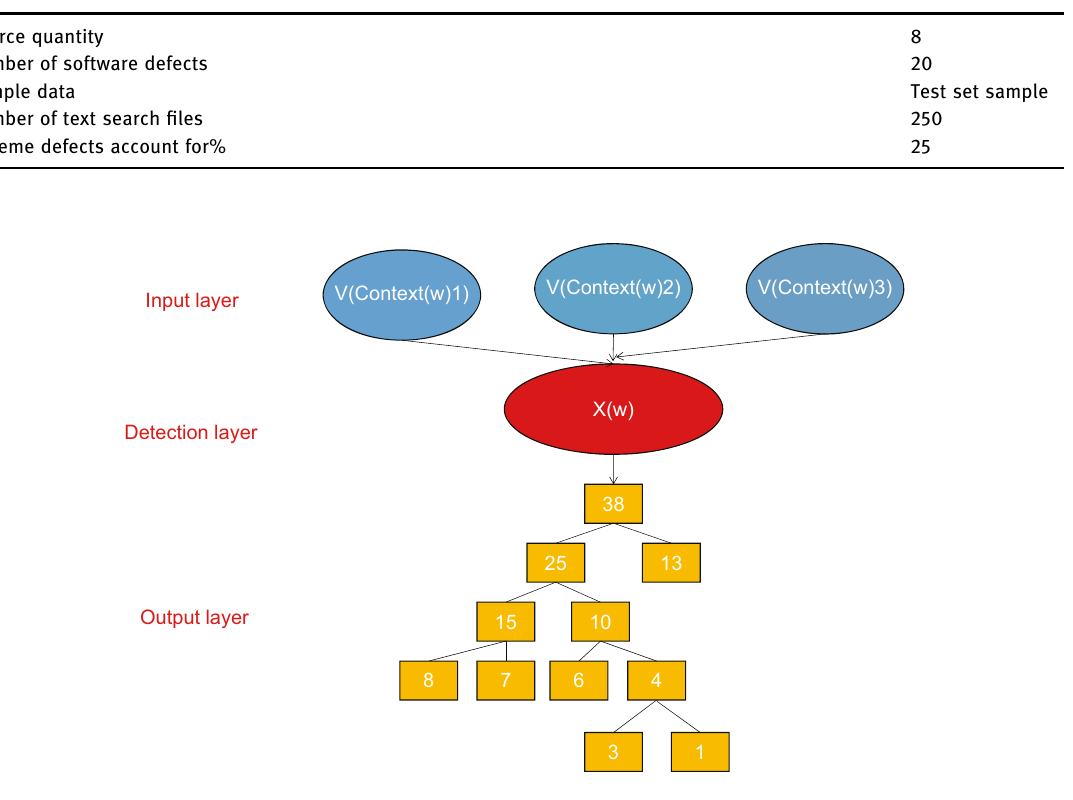
Figure 5: Detection operation